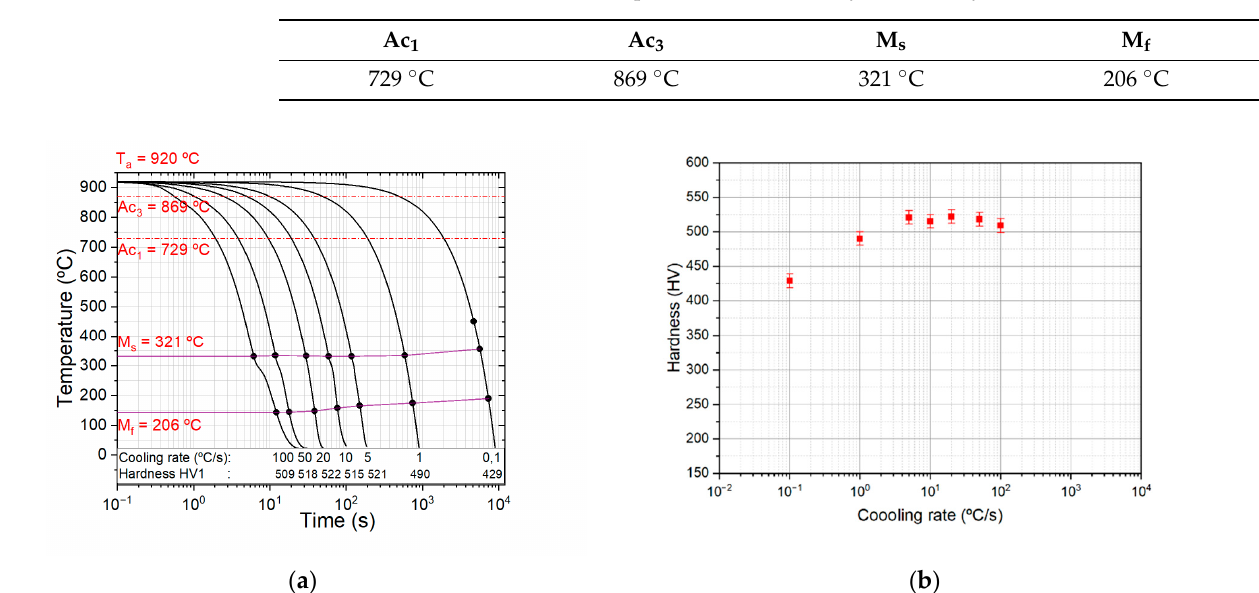
Figure 4. ( a ) Continuous cooling transformation (CCT) diagram of the present steel, ( b ) hardness values in each CCT condition.